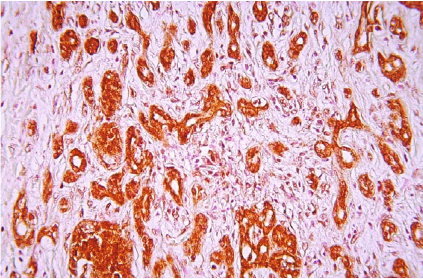
Figure 11: Immunohistochemical staining, MMP-7 (3+), × 100.